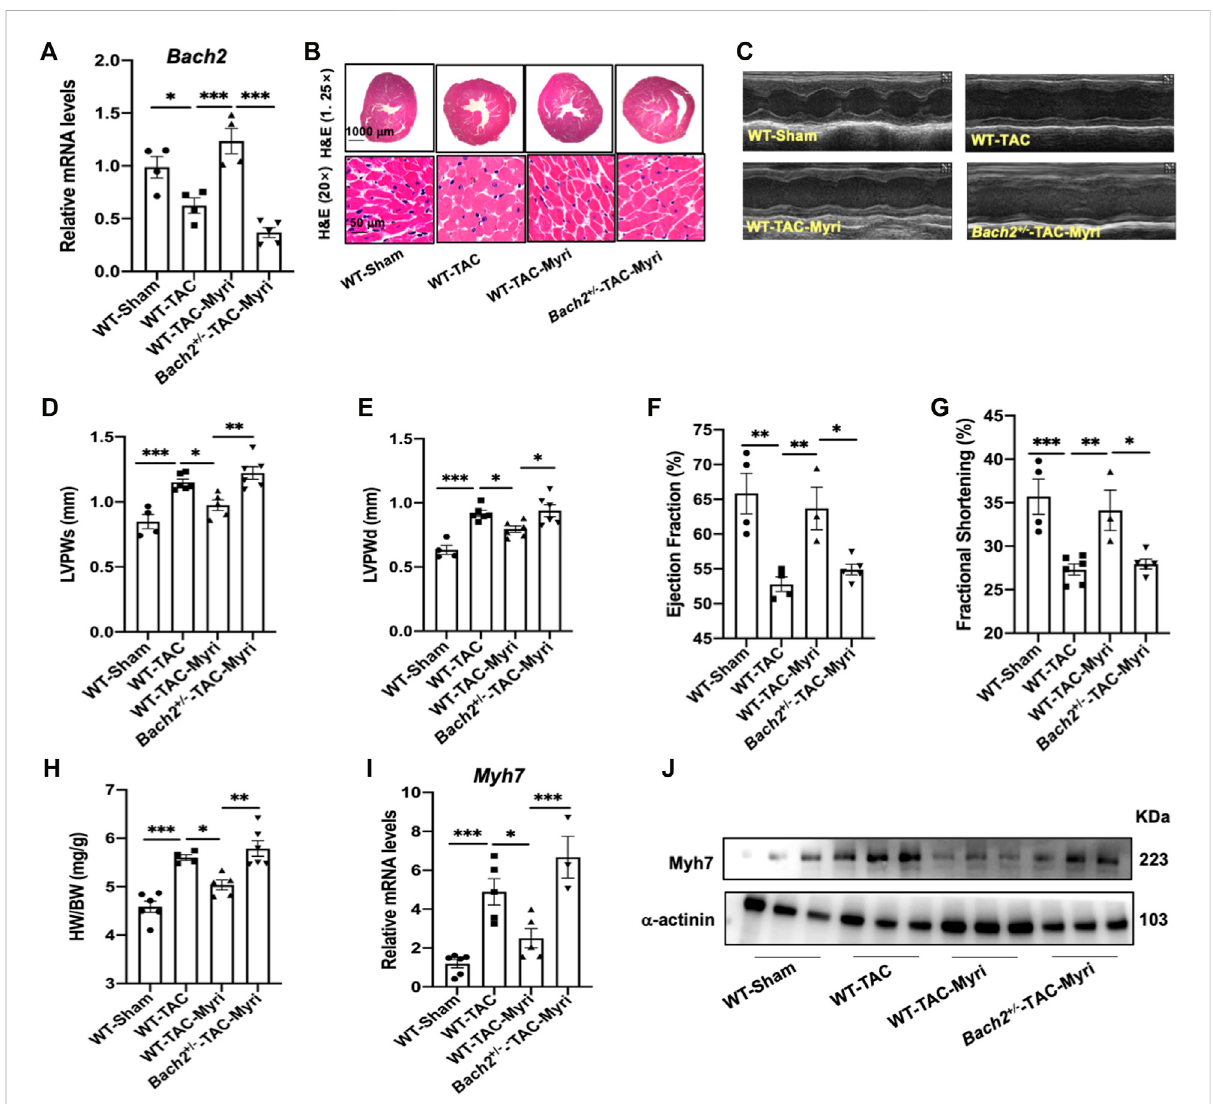
FIGURE 6 Myricetin attenuates TAC-induced cardiac hypertrophy and failure partially via upregulating BACH2 expression levels in vivo. (A) Bach2 transcriptional levels in the indicated groups of mice (n=4-6). (B) Representative H & E images showed heart transverse sections. (C) The representative M- mode echocardiographic images. (D – G) Echocardiographic indicators showed that myricetin treatment alleviated TAC-induced wall thickening and cardiac dysfunction whereas this effect was blocked in the Bachr1 · mice . (H) Heart weight/Body weight (HW/BW). (l – J) The mRNA and protein level of Myh 7 in the indicated groups. * P < 0.05, ** P < 0.01, *** P <